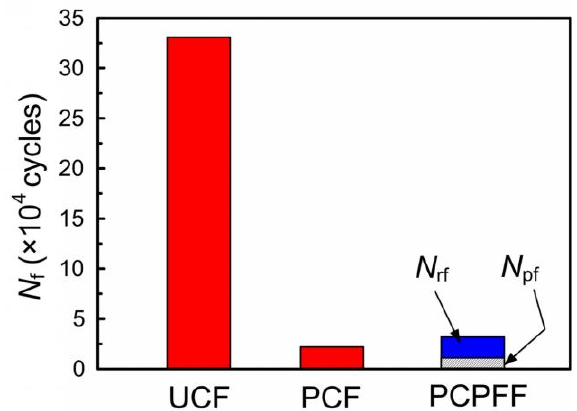
Figure 5. Average fatigue lives of different 7085-T7452 aluminum alloy specimens: N f , N pf , and N rf are the total fatigue life, prefatigue life, and residue fatigue life, respectively.